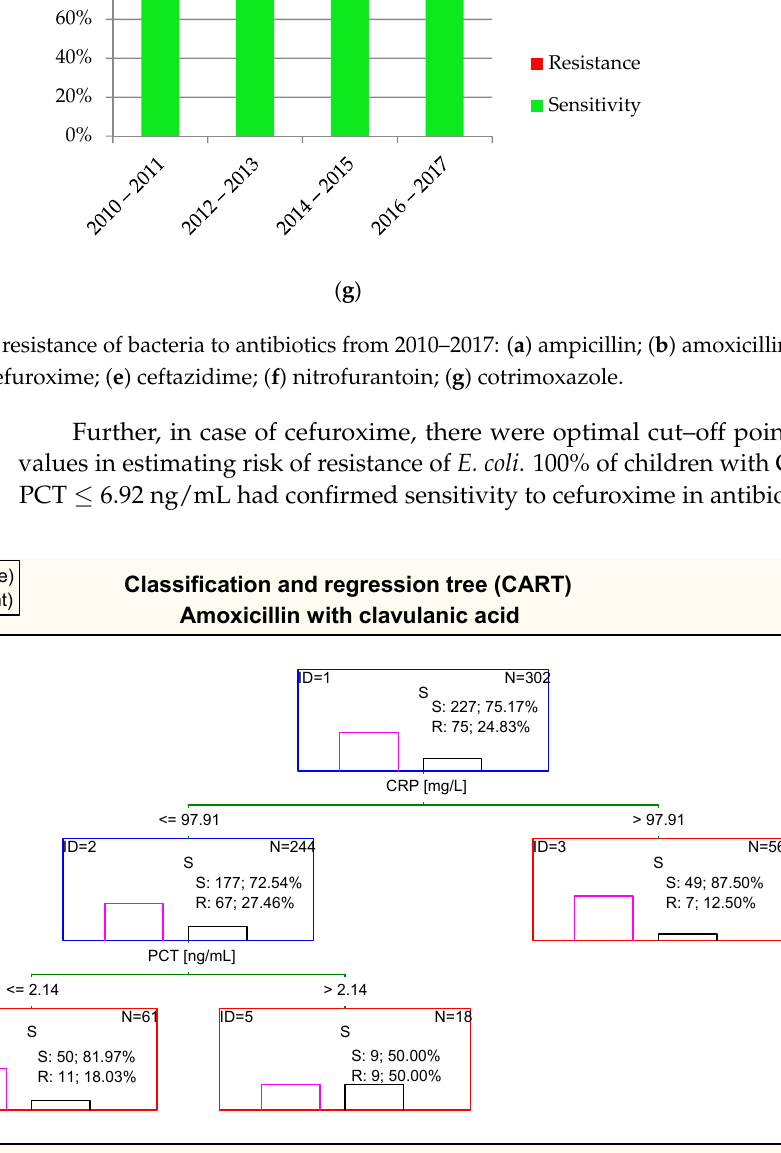
Figure 11. Classification and regression tree (CART) for resistance of Escherichia coli to amoxicillin with clavulanic acid created on basis of inflammatory markers.